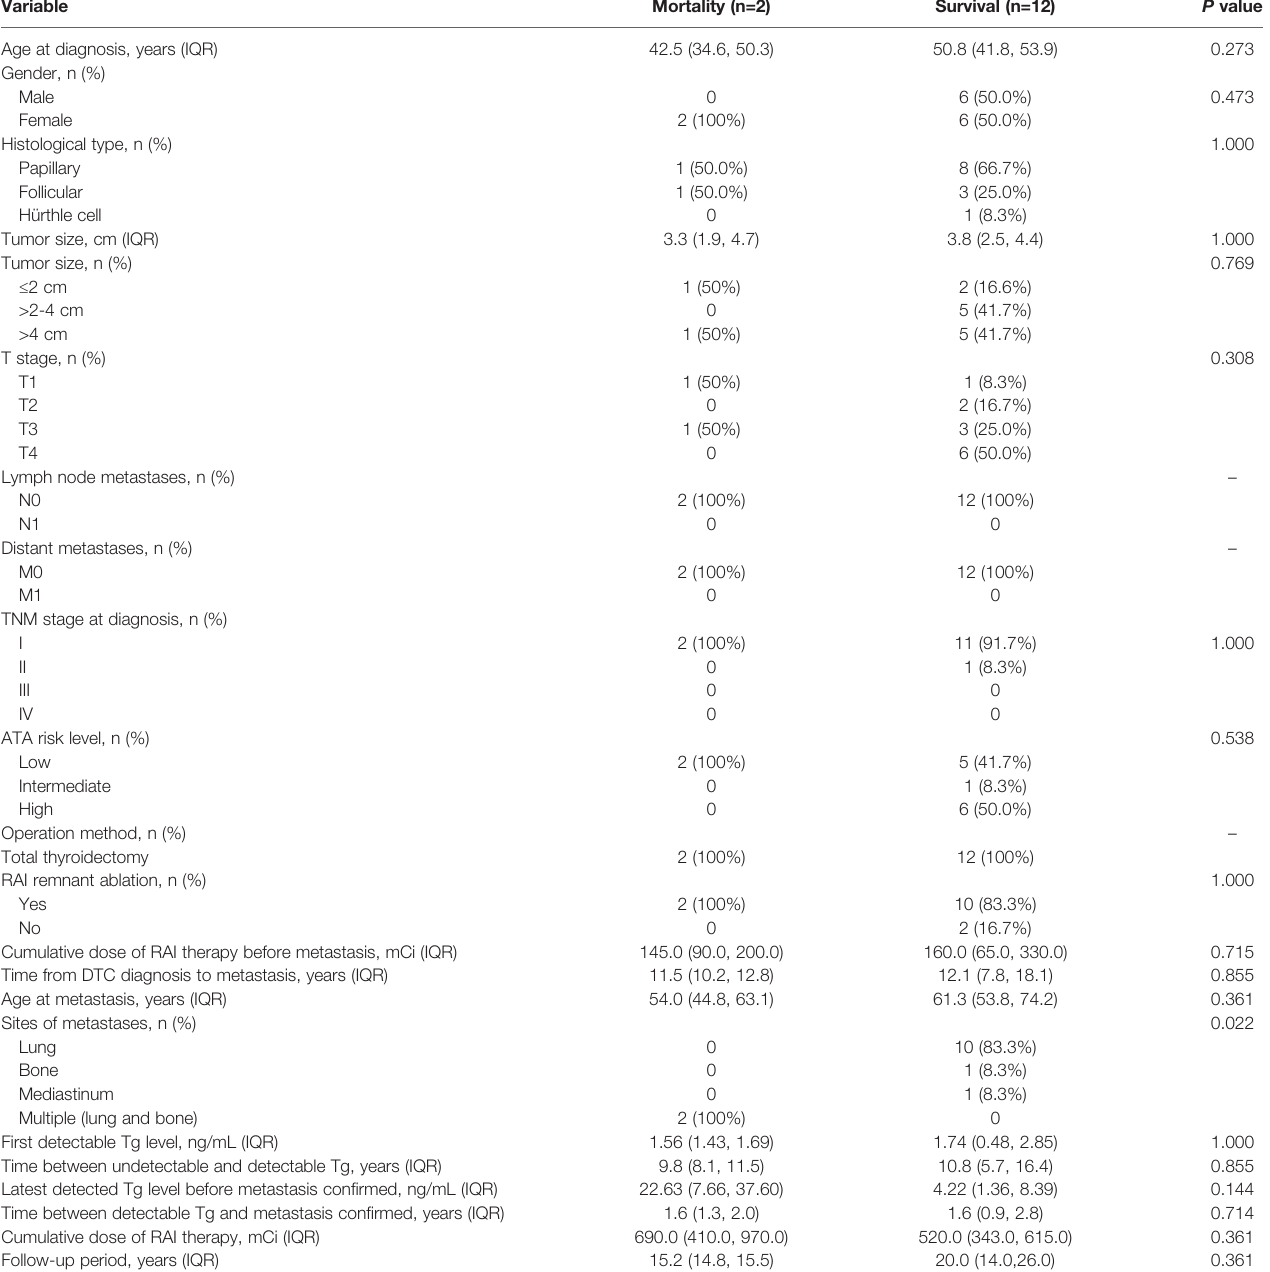
TABLE 3 | Risk factors associated with disease-speci fi c mortality in 14 patients with distant